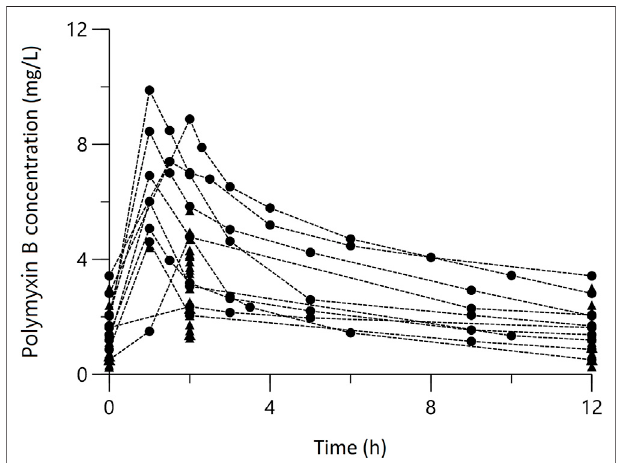
FIGURE 1 | Concentration-time pro fi le of Polymyxin B at steady state. The circles represent multiple-time point sampling; the triangles represent two-time point sampling.